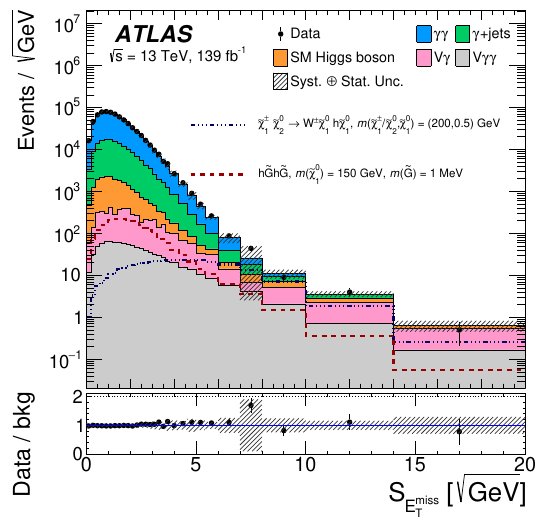
Figure 3 . The distribution of S after the selection of diphoton candidates with 120 < m (cid:13)(cid:13) < E miss T ! W (cid:6) ~ (cid:31) 0 130 GeV. Expected distributions are shown for the ~ (cid:31) (cid:6) ~ (cid:31) 0 h ~ (cid:31) 0 signal with m (~ (cid:31) (cid:6) = ~ (cid:31) 0 ) = 1 2 1 1 1 2 200 GeV and m (~ (cid:31) 0 ) = 0 : 5 GeV, and the h ~ Gh ~ G signal with m (~ (cid:31) 0 ) = 150 GeV and m ( ~ G ) = 1 MeV. 1 1 These overlaid signal points are representative of the model kinematics. The sum in quadrature of the MC statistical and experimental systematic uncertainties in the total background is shown as the hatched bands, while the theoretical uncertainties in the background normalisation are not included. The tt(cid:13) and tt(cid:13)(cid:13) processes have a negligible contribution and are not represented. Over(cid:13)ow events are included in the rightmost bin. The lower panel shows the ratio of the data to the background, called